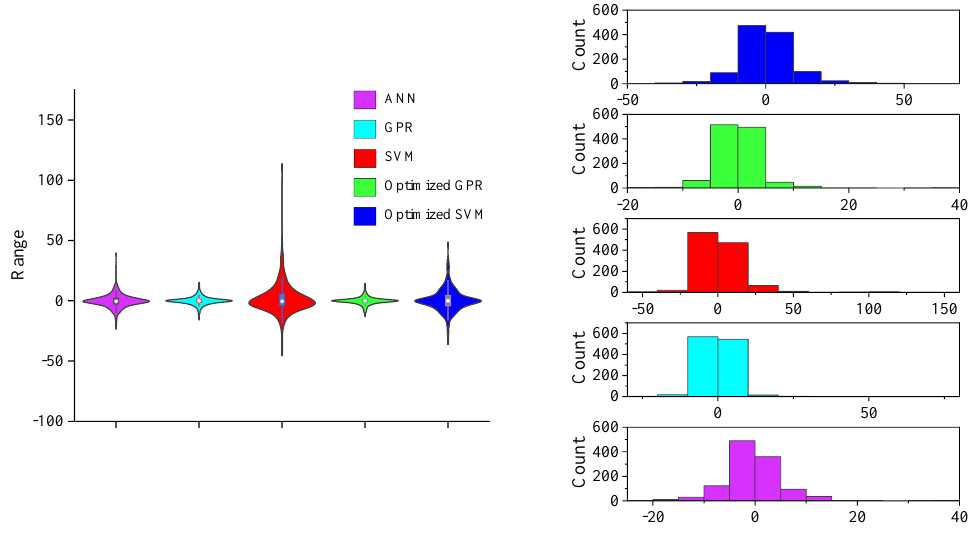
Figure 13. Violin with box plot and frequency distribution of errors.